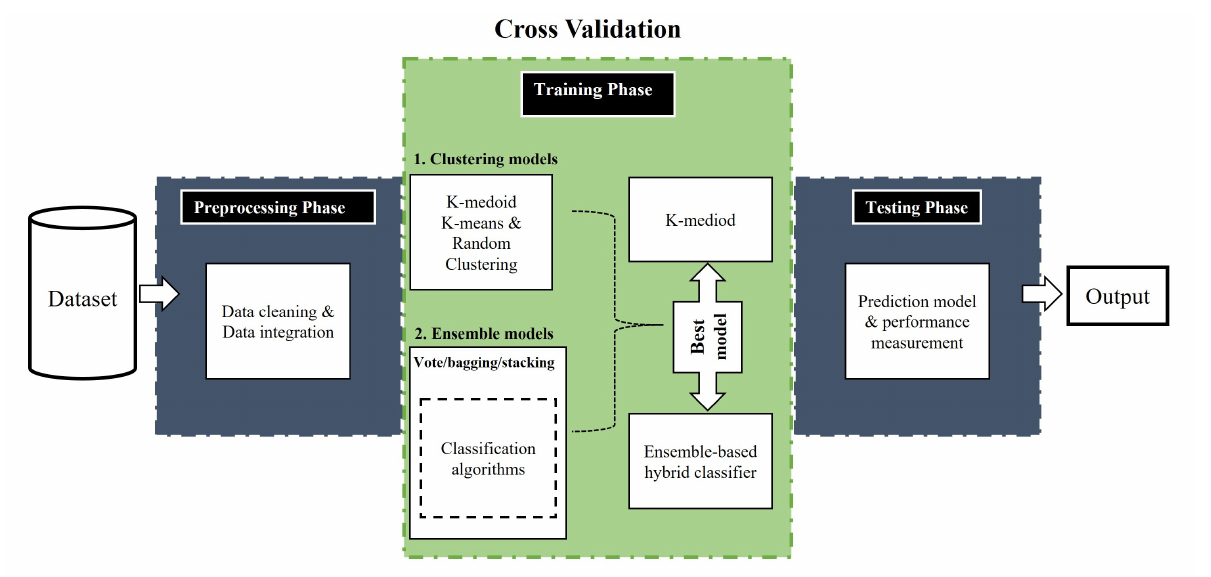
Figure 1. Proposed CCP framework.